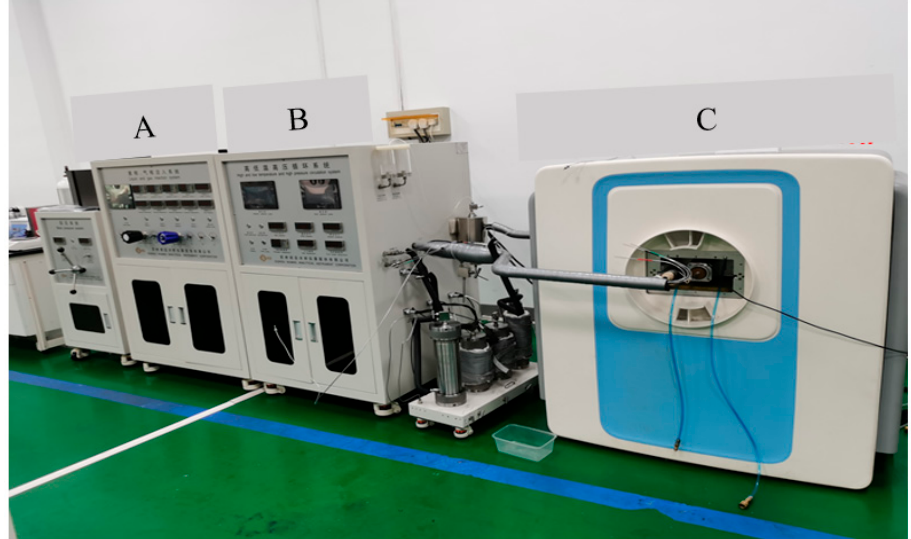
Figure 4. MicroMR12-110H-GS-HTHP NMR system with displacement and confining stress loading equipment ( A —injection system, B —temperature and pressure control system, C —NMR system with the displacement device).